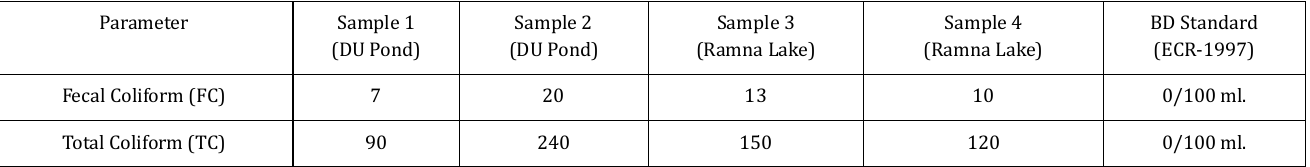
Table 4: Results of Coliform